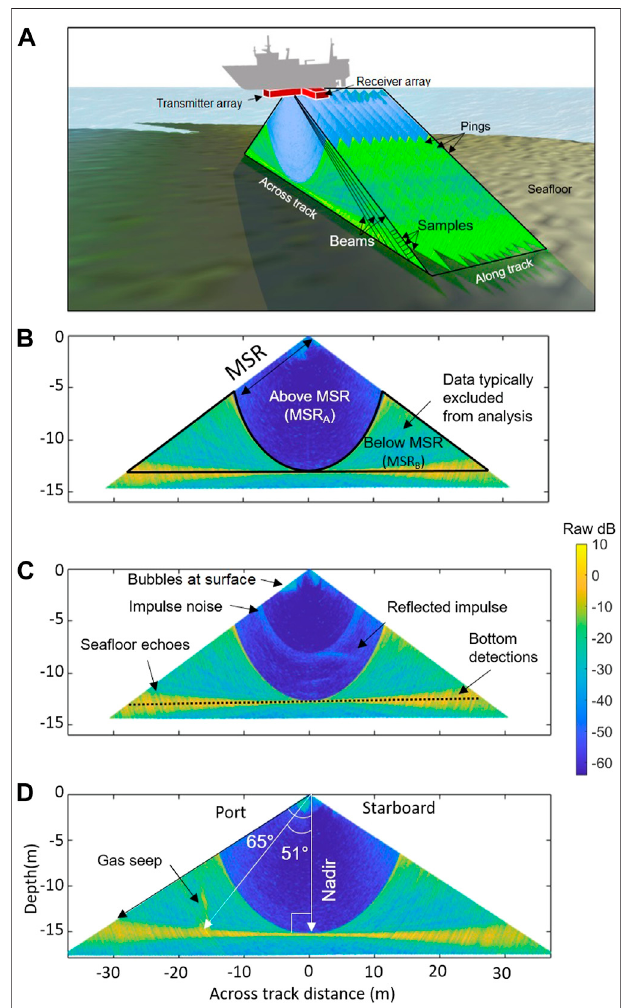
FIGURE 1 | (A) 3-D depiction of a Mills Cross multibeam system with a transmitter array mounted perpendicular to the receiver array below the ship. Multiple pings make up the sampling insoni fi ed volume, and each ping is further broken down into beams and samples. (B) Demonstrates the terminology for the minimum slant range (MSR) and the areas of data encompassed above minimum slant range (MSR A ) and below minimum slant range (MSR B ). MSR A , dominated by blue shows the “ clean ” area of the WCD that is generally not impacted by sidelobe interference. MSR B dominated by green demonstrates the data impacted by sidelobe interference due to the strong nadir sea fl oor return in all beams and samples beyond the MSR. (C) ShowsexamplesofvarioustypesofnoisewithintheWCD.Bottomdetections are indicated by the black dotted line. The yellow samples surrounding the bottom detections are the spreading echoes of the sea fl oor return. (D) Demonstrates the beam pointing angles. Nadir is 90 ° from the transducer parallel to the surface and pointing directly down to the sea fl oor. The swath width ofa single side (port/starboard) ofthe data isshown as65 ° . Areal water column feature is shown which is a gas seep fully enclosed within MSR B . The beam pointing angle to the base of the seep target in this case is 51 ° . Colors within each WCD ping represent raw